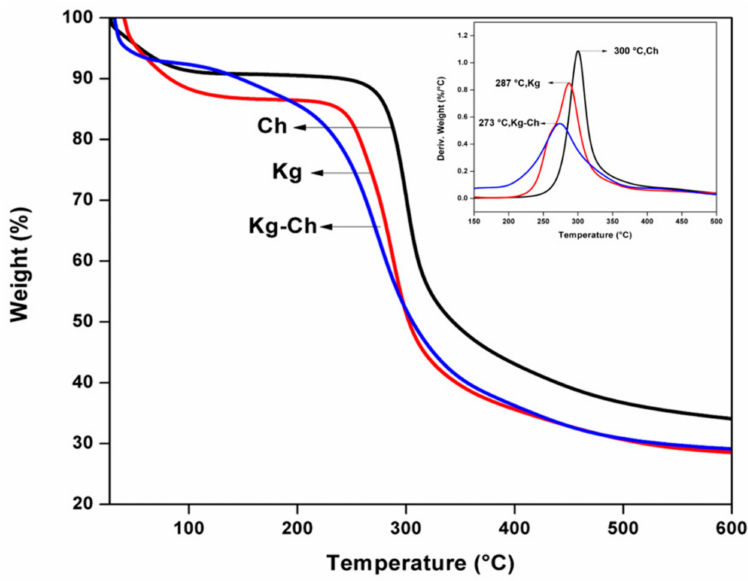
Figure 4. Thermograms showing weight percent as a function of temperature for Ch, Kg, and Kg-Ch sponge (derivative thermogravimetric curve